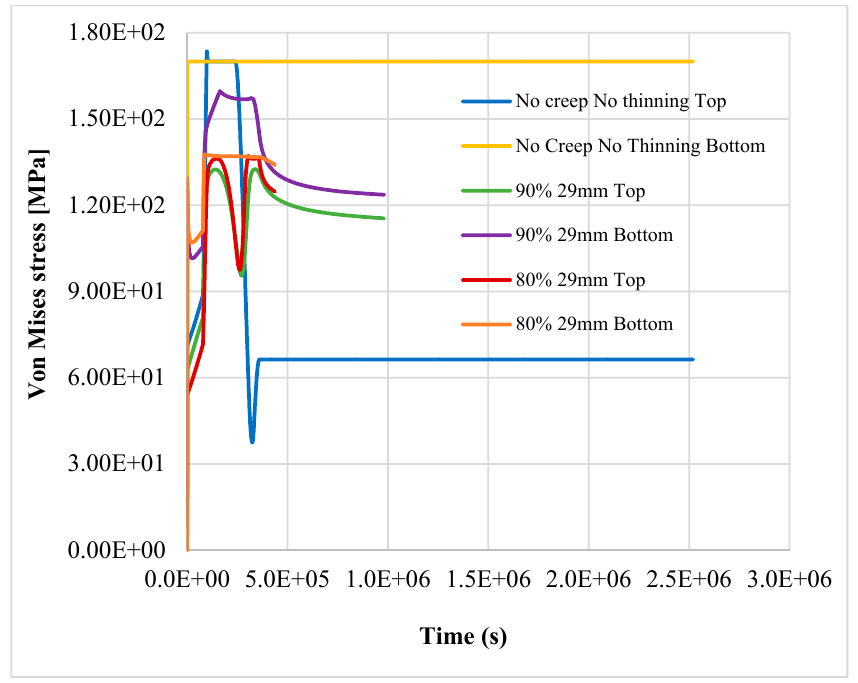
Figure 9. Top and bottom equivalent layers of equivalent von Mises stress away from thinning— case 1 (reference), case 4, case 5.